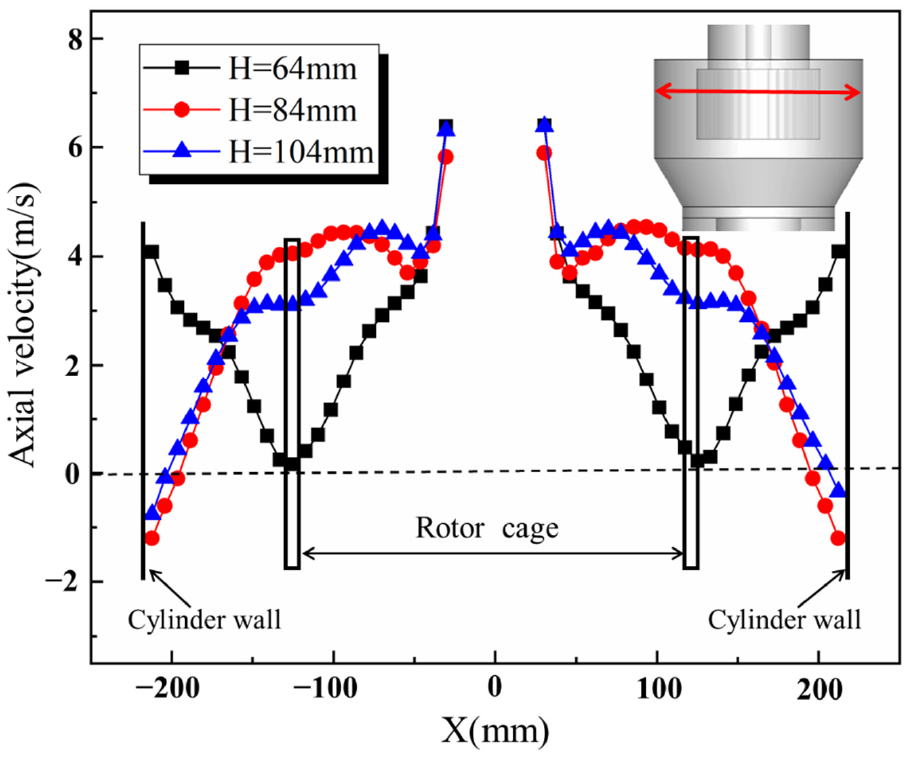
Figure 5. Effect of the guide cone height on the axial velocity (Z = − 37.5).